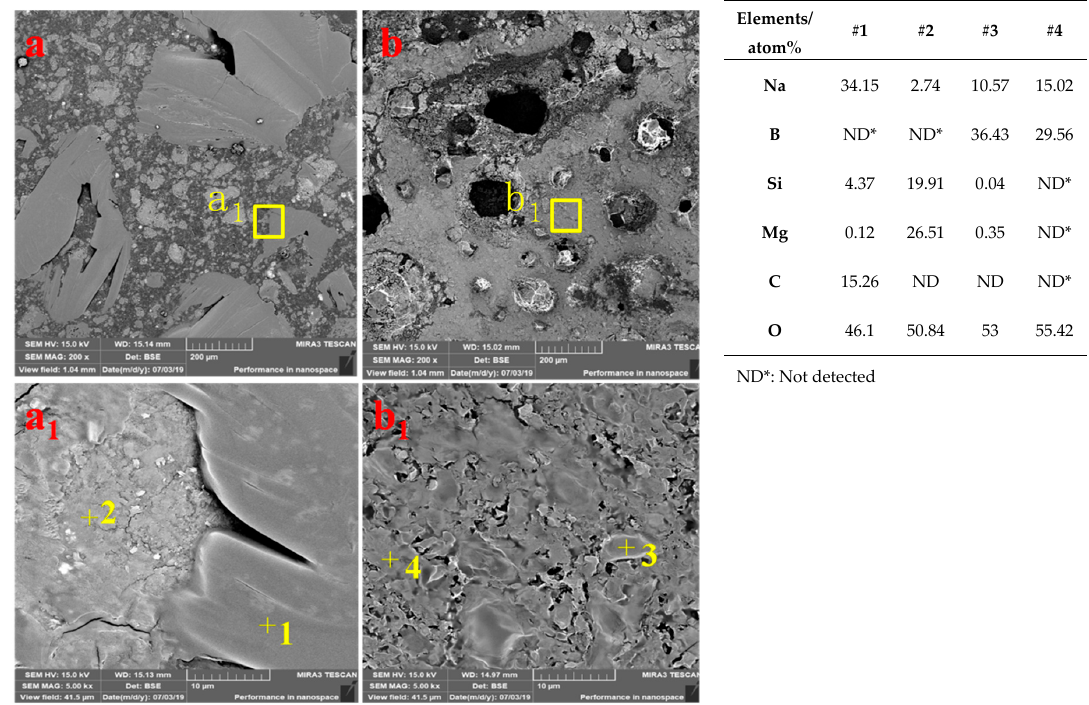
9 of 11 Figure 9. XRD patterns ( a ) mixture of lizardite and sodium carbonate (lizardite to sodium carbonate molar ratio 1:2) and ( b ) mixture of szaibelyite and carbonate (szaibelyite to sodium carbonate molar ratio 1:1) roasted at 1000 °C for a different time in nitrogen atmosphere. Dm—Disodium magnesiosilicate (Na 2 MgSiO 4 ); P—Periclase (MgO); Sb—Sodium borate. 3.3.3. Microstructure SEM images and corresponding EDS results of the mixtures both roasted at 800 °C for 60 min